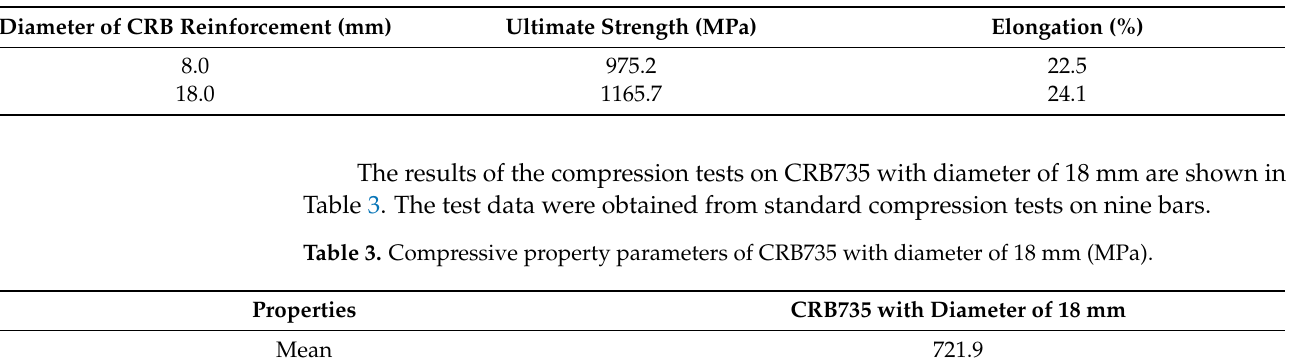
Table 2. Ultimate strength and elongation of CRB735.